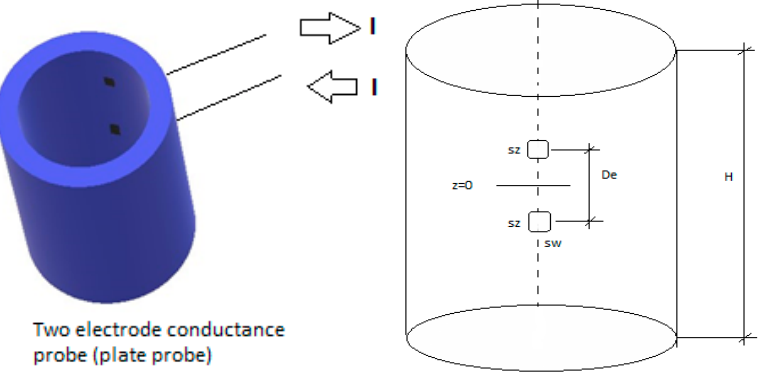
Figure 3. Two-plate electrode probe along the direction of the pipe axis.